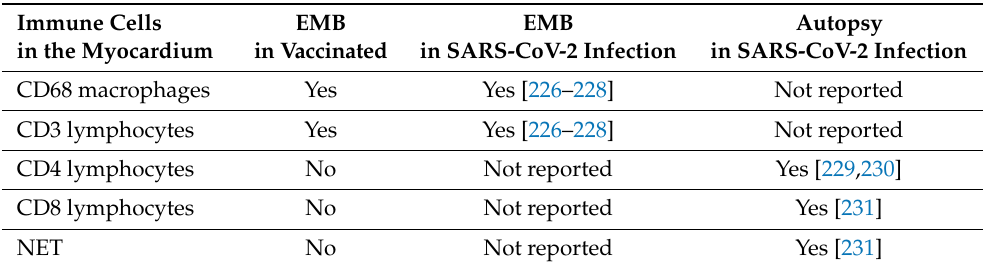
Table 3. Immune cells infiltrating the myocardium in three different types of subjects affected by